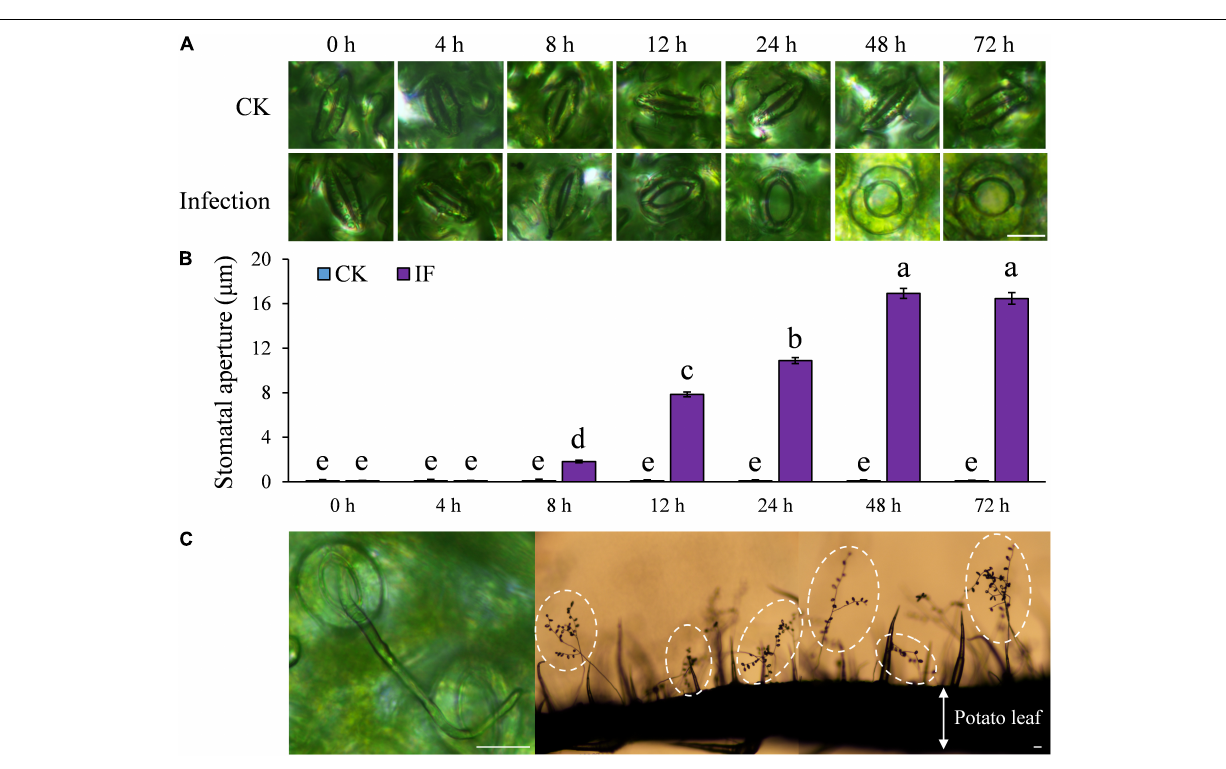
FIGURE 3 | Stomatal aperture was significantly increased after P. infestans inoculation under dark condition: (A) Images showing stomatal aperture of potato leaves increased after the successful colonization of P. infestans ; (B) stomatal aperture started to increase from 8 h post infection (hpi), and reached the maximum size at 48 hpi; and (C) images showing that sporangiophores emerged through opened potato stomata 72 hpi and a large amount of sporangia (the lemon-shaped spots in dashed circles) were formed 4–5 days post inoculation. The marker = 20 µ m. Photos within a panel are from a representative of a single replicate while photos among panels are pooled from multiple